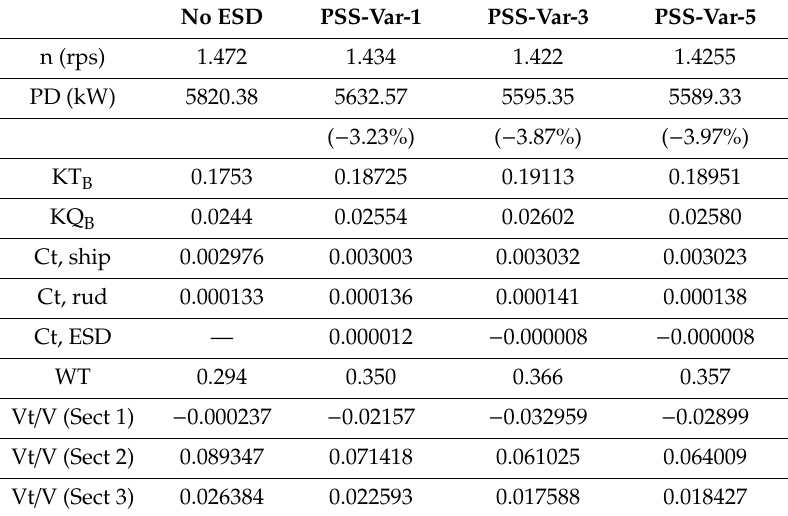
Table 5. Performance characteristics of the ship equipped with the three PSS designs. CFD predictions at design speed (14 knots) on a full